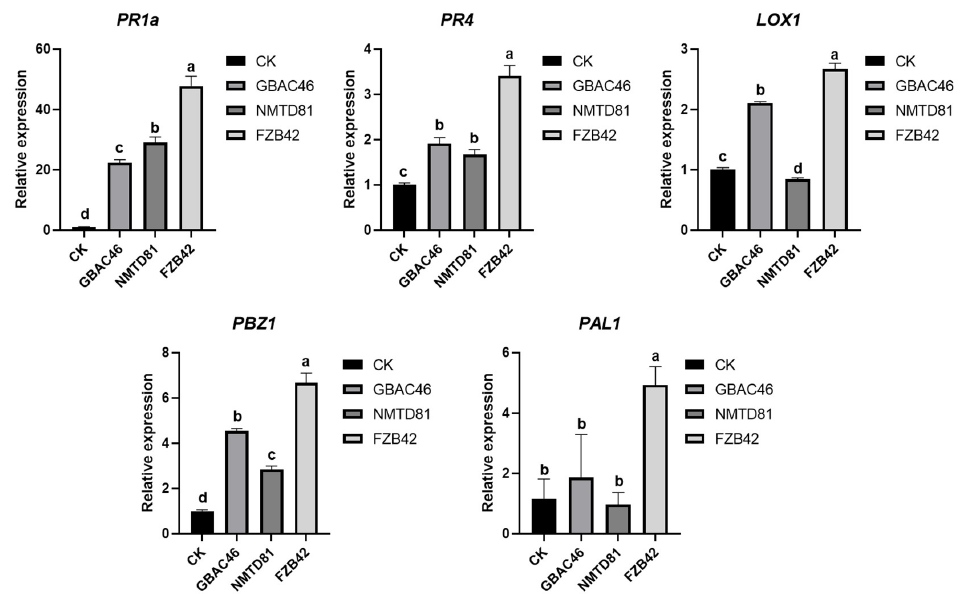
Figure 8. Relative expression analysis of defense genes PR1a, PR4, LOX1, PBZ1, and PAL1 in rice plants infested with A. besseyi and treated with Bt strains. The error bars indicate the mean standard deviation of each treatment when replicated three times. Significant differences are indicated by the letters above the columns. Fisher’s LSD test was used to determine significant differences between treatments at p ≤ 0.05.